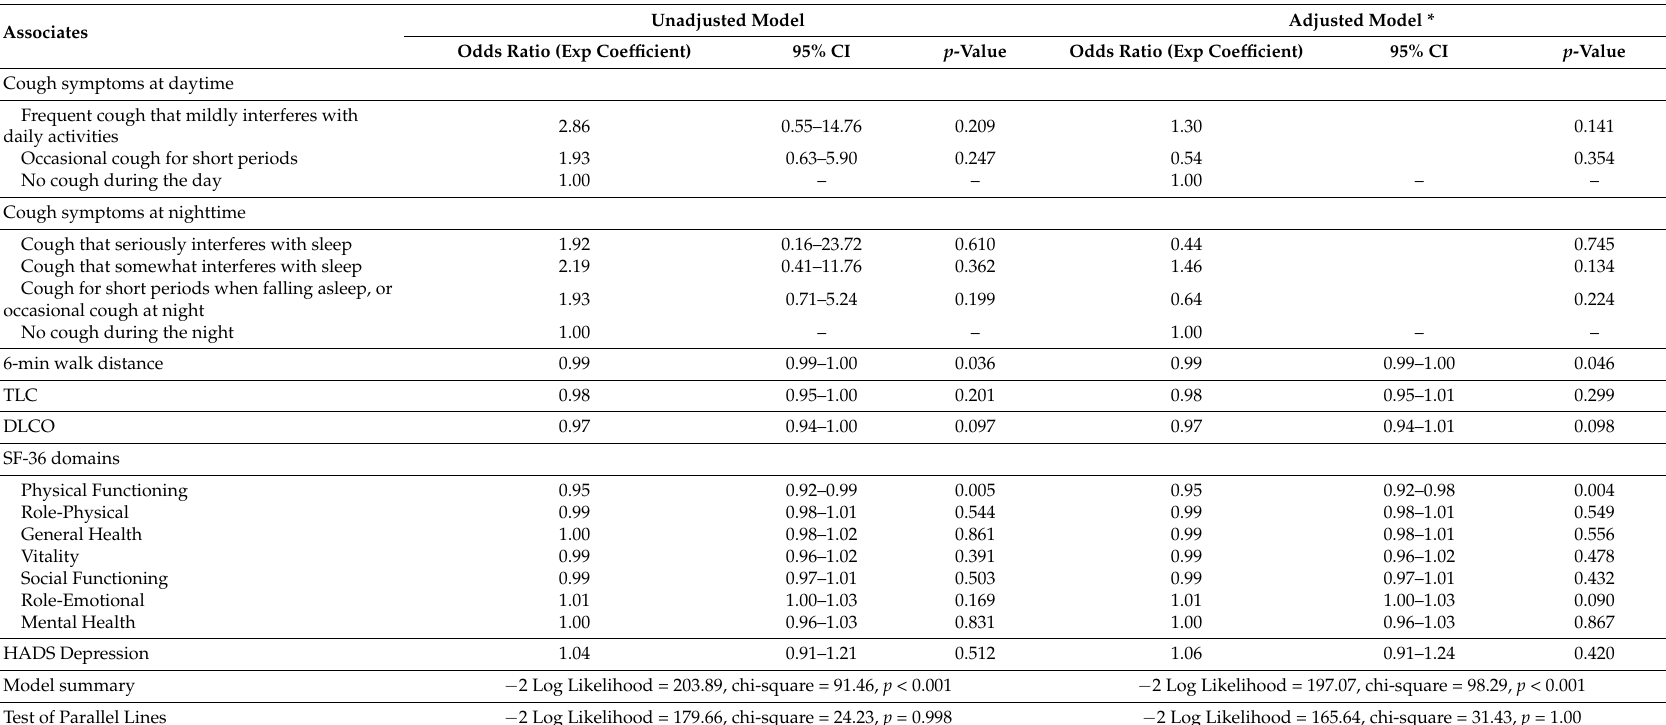
Table 4. Results of Ordered Logistic Regression Analysis (MRC grade as the dependent variable) ( n =